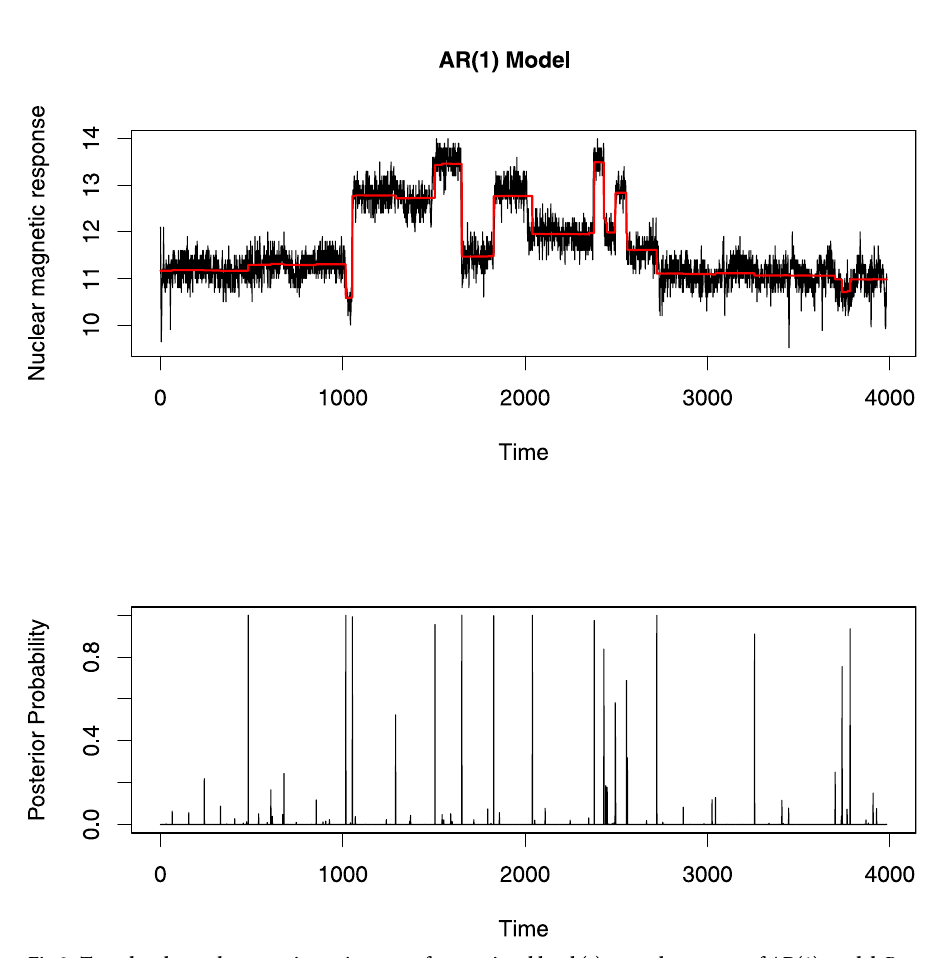
Fig 9. Top plot shows the posterior estimators of mean signal level (c) on each segment of AR(1) model. Bottom plot shows the posterior probability of a change-point at each position. These segment means and change-point positions indicate significant jumps in the original